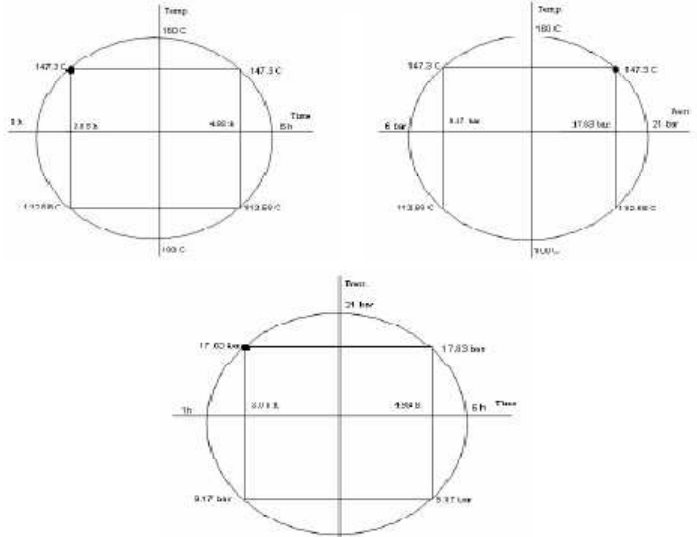
Fig. 4 . Points of a central composite circumscribed design with three input